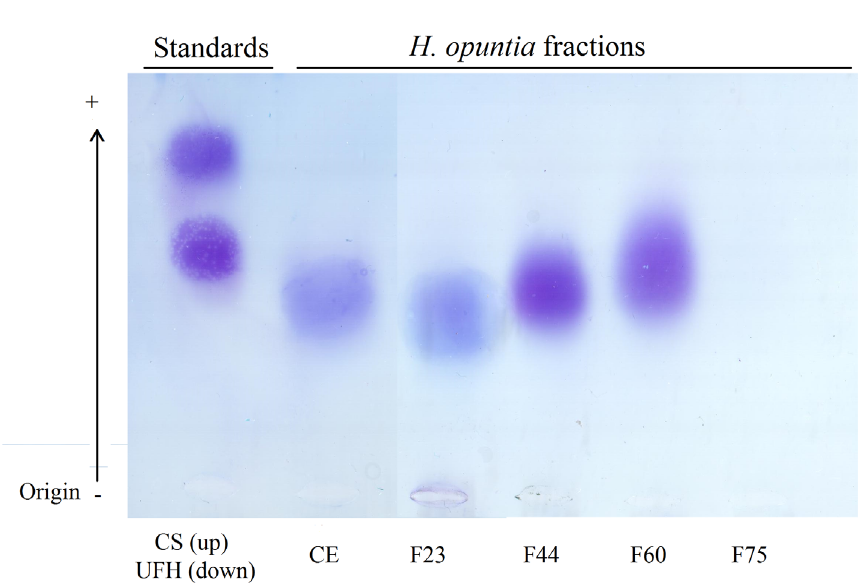
Figure 1. Agarose gel electrophoresis of ethanol- precipitated SP fractions (F23, F44, F60 and